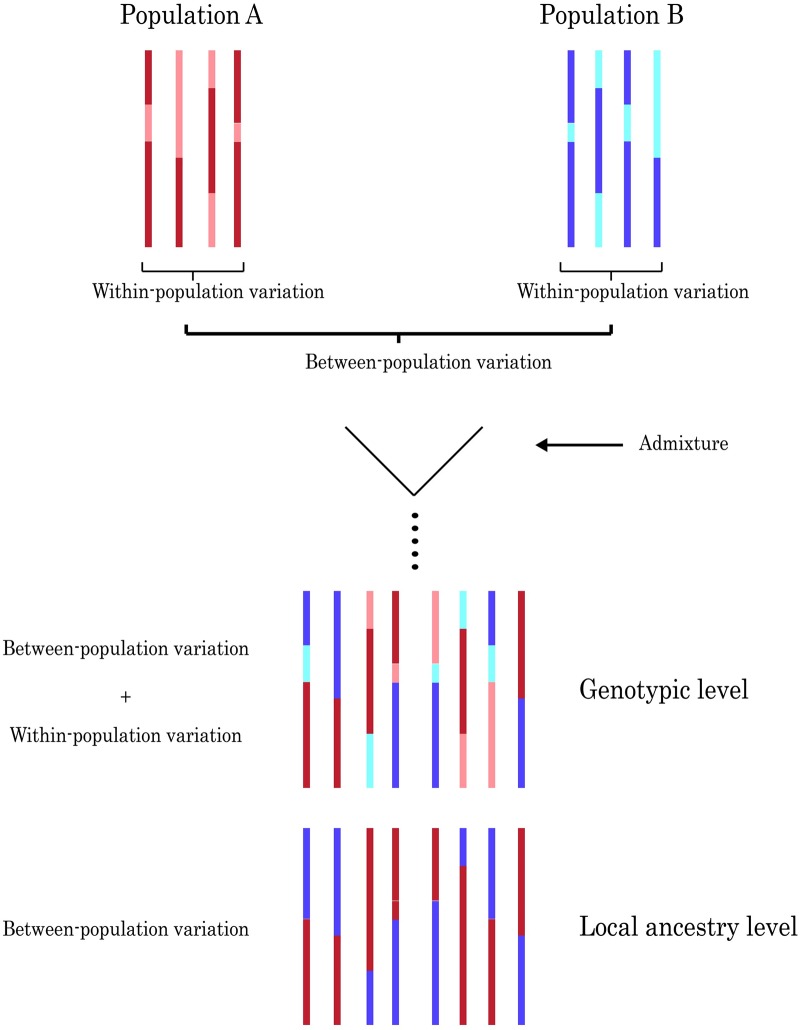
Admixture brings together within- and between-population variation in admixed individuals.Genetic variation between the two parental populations is represented by difference in color of the chromosomes, whereas genetic variation within the populations is represented by hue intensity. Admixture brings together genetic variation from both populations. On a genotypic level, genetic variation within admixed populations is composed of both within-population and between-population variation. The variation at the level of ancestry is variation between the two parental populations.